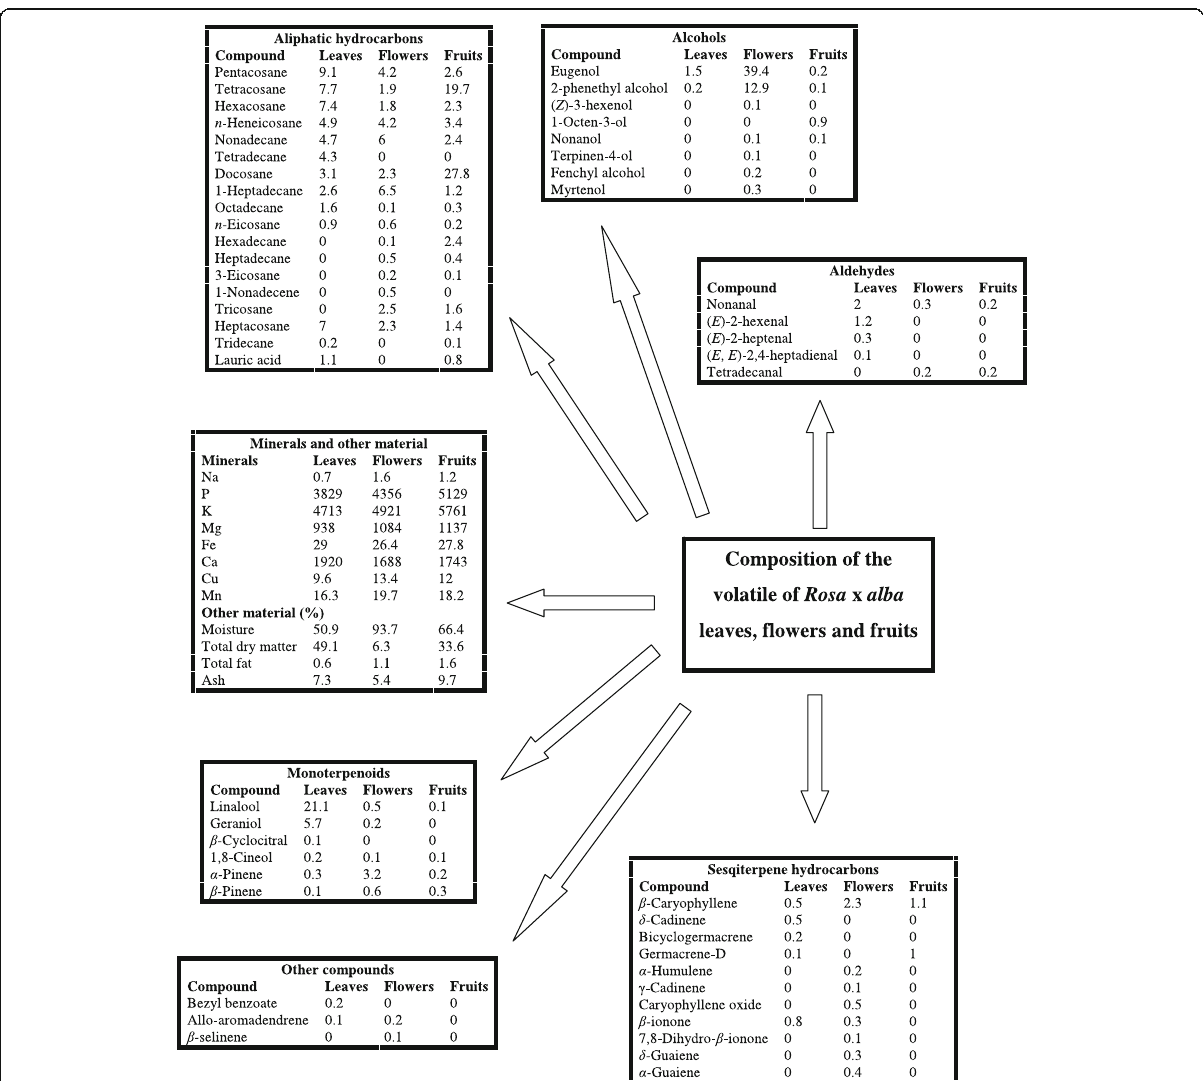
Fig. 2 Composition of the volatile oil (% peak area) of Rosa x alba leaves, flowers and